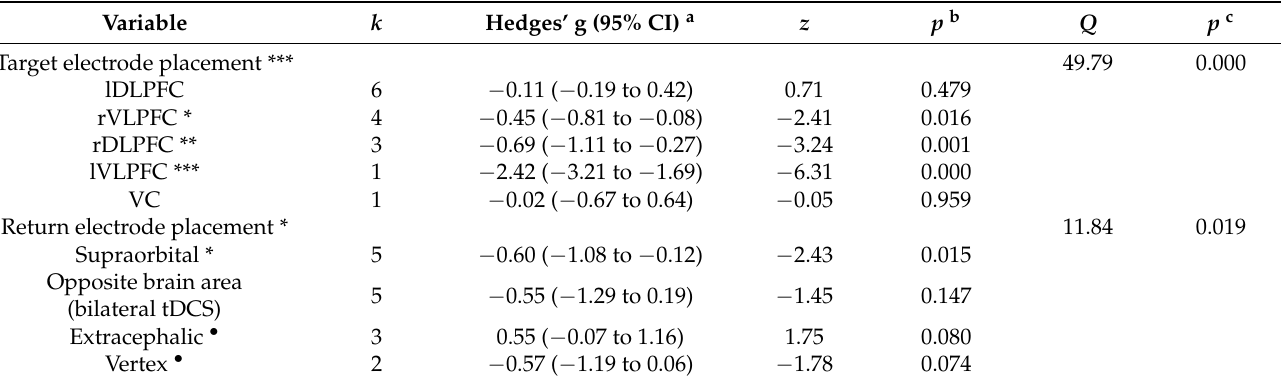
Table 3. Results of subgroup analyses for categorical